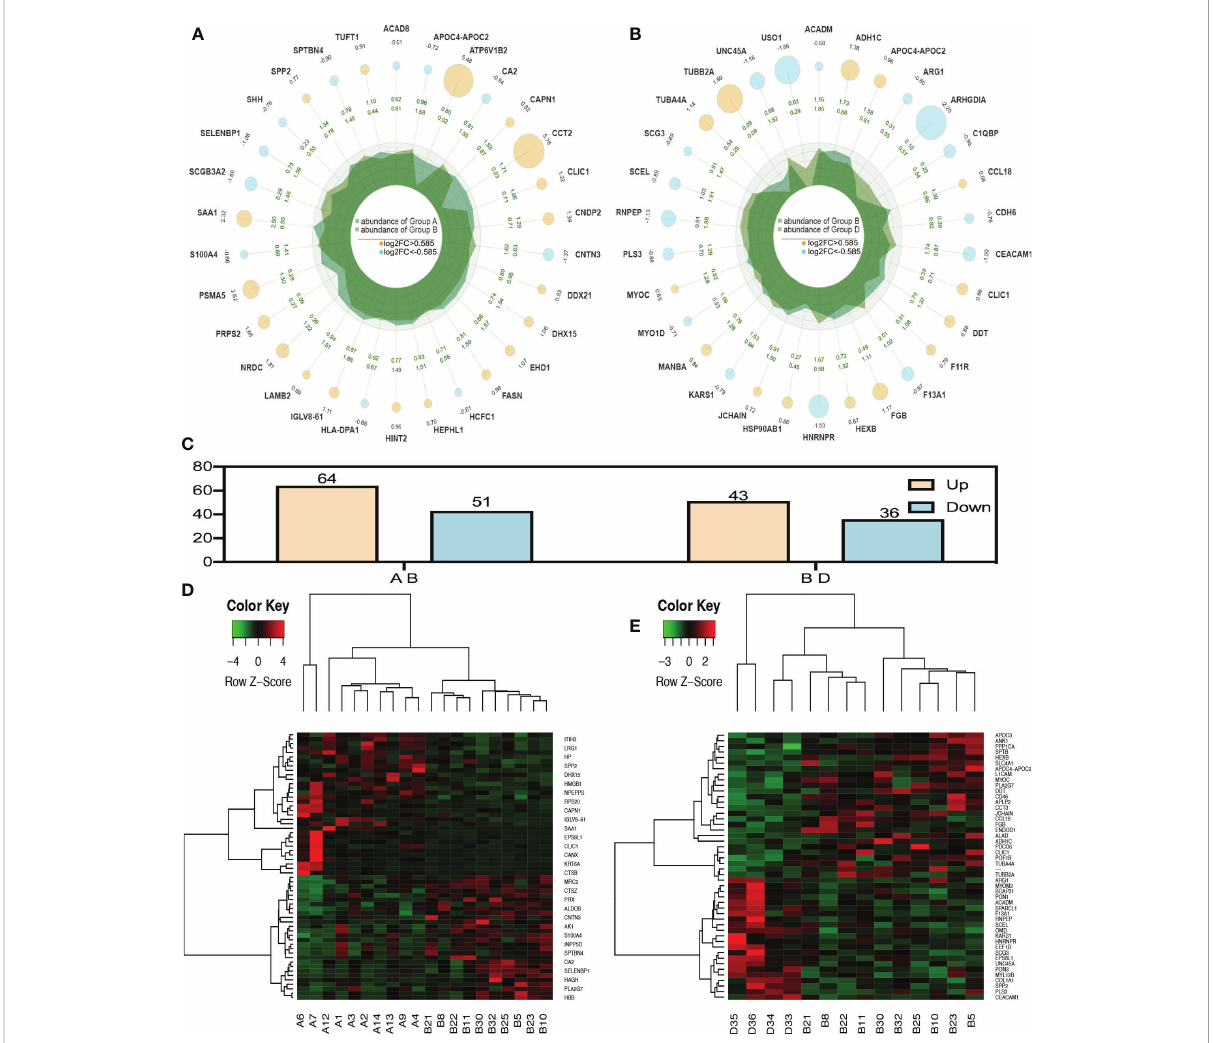
FIGURE 1 Radar plot and heatmap of differentially expressed proteins in various groups. (A, D) showed fold changes for proteins differentially expressed between group A and group B while (B, E) Are DEPs between group B and group D. In the Radar plot yellow circle and sky blue circle: